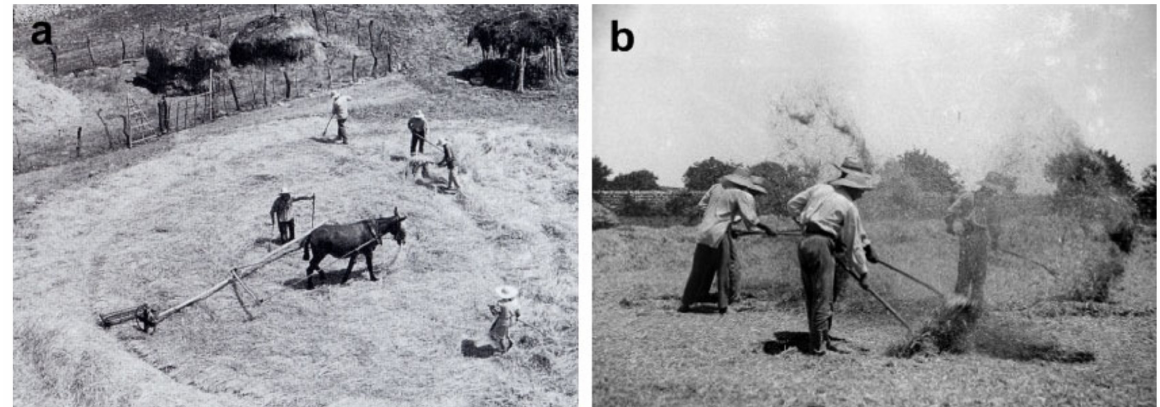
Figure 5. ( a ) Threshing inside a Mallorcan threshing floor. The circular direction in which the threshing is carried out is adapted to the circular plan of the threshing floor. Photo: Solcs i Ones [45]; ( b ) winnowing inside the threshing floor. Photo: Ferran